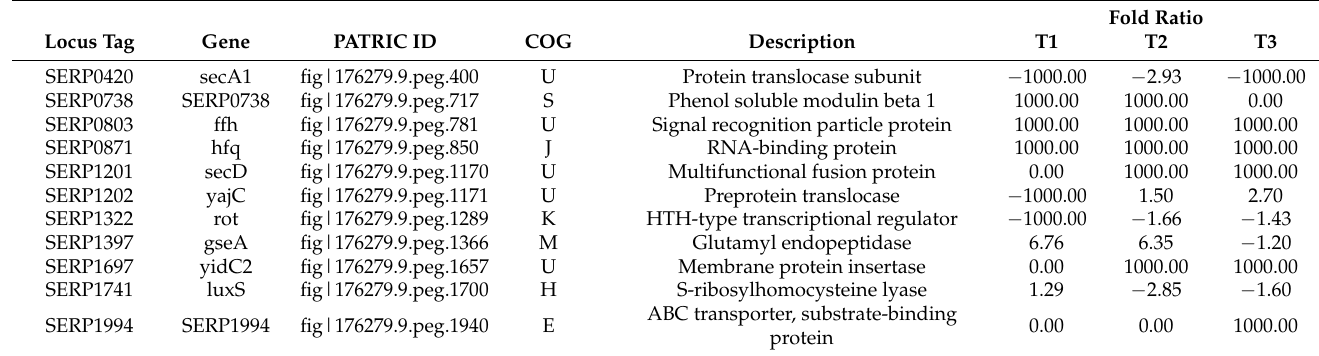
Table 4. Differentially expressed proteins associated with quorum sensing.